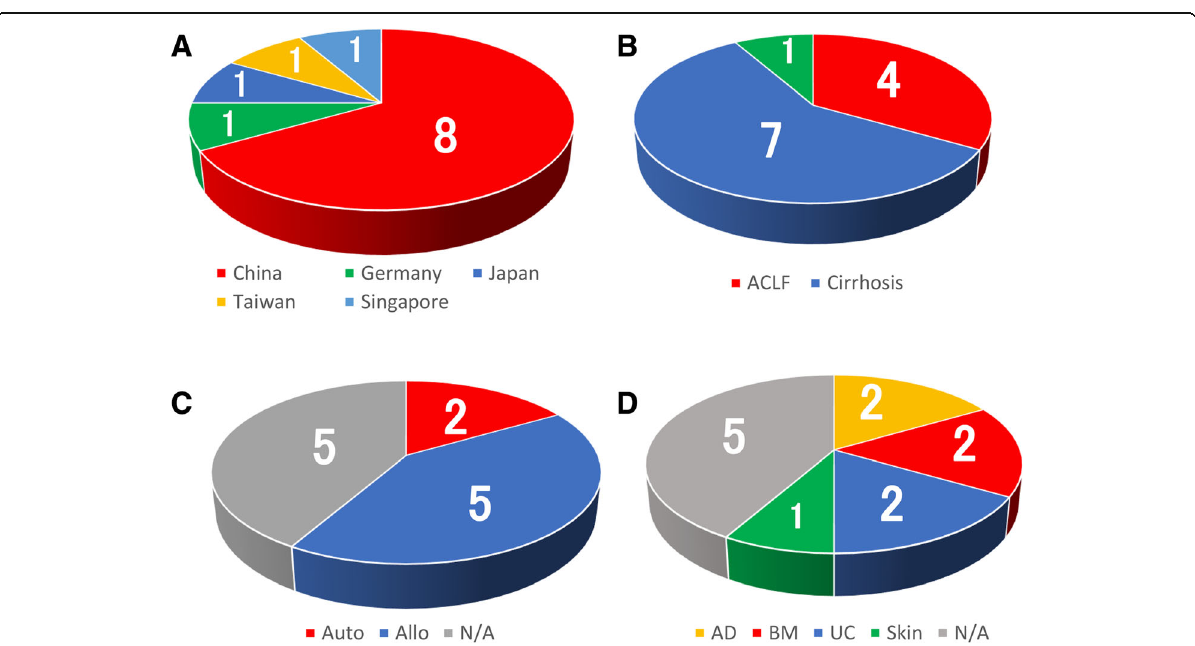
Fig. 2 Recent trends in clinical trials using MSCs. Proportion of country ( a ), disease conditions ( b ), autologous or allogeneic ( c ), and tissue origin of MSCs ( d ) in recent clinical